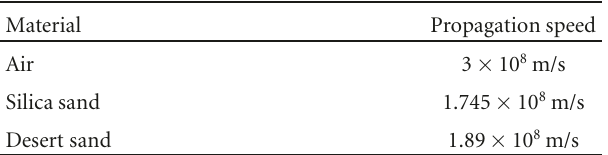
Table 2: Propagation speed values of materials found in BMI and MWI scan